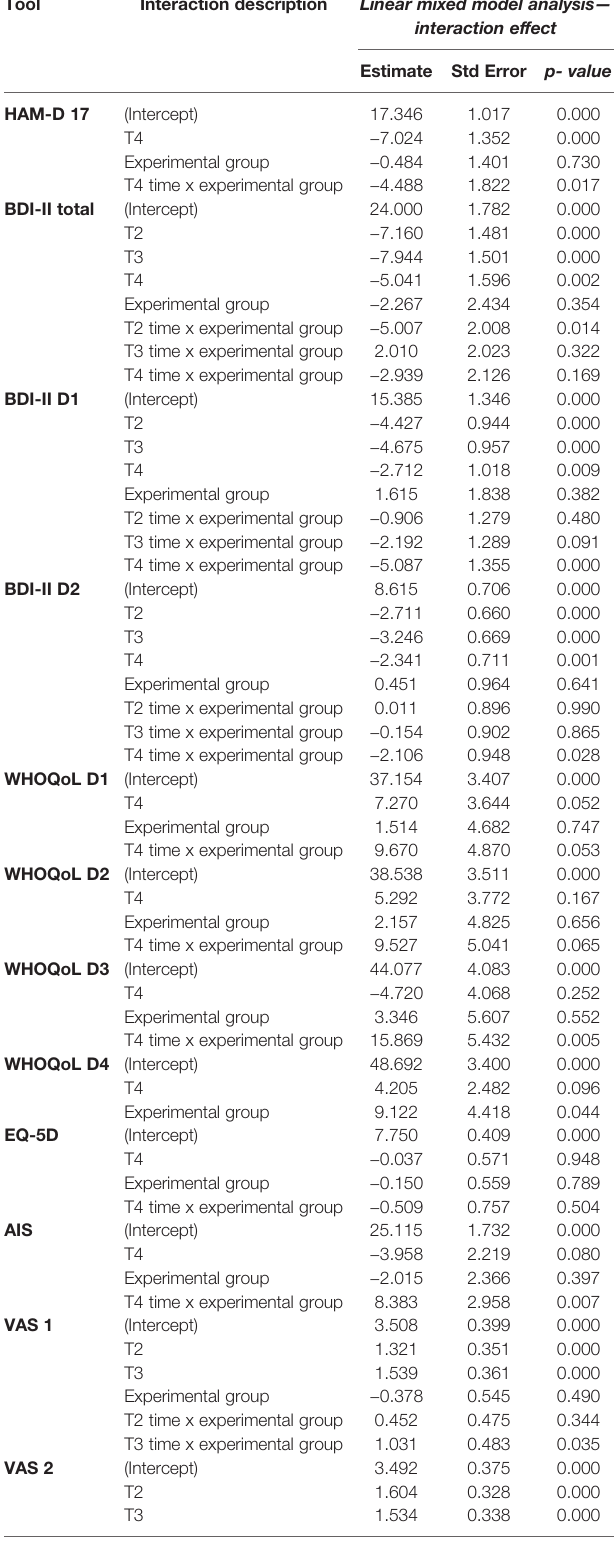
TABLE 4 | Linear mixed model analysis results (T1, T2, T3, T4). Tool Interaction